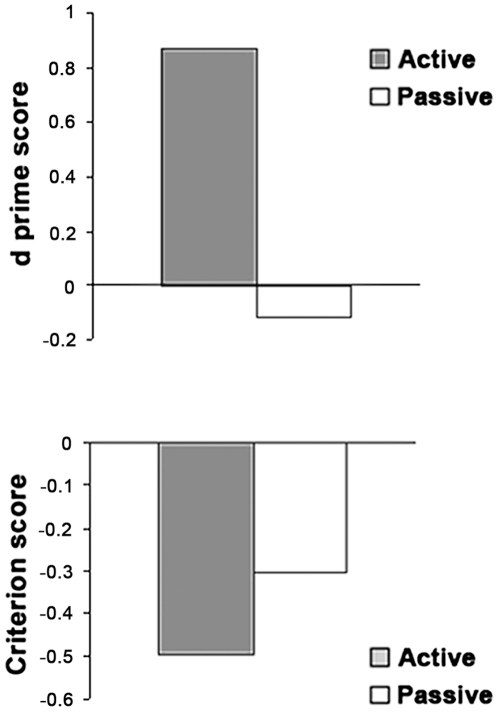
Signal Detection analysis of behavioural responses by conditions of movement ownership.
Upper panel: Sensitivity (d') in the active vs. passive condition. Lower panel: Criterion or response bias in the active vs. passive condition. Subjects were better at making the self vs. other discrimination (p<.05) and tended to judge the viewed hand to be their own in the active relative to the passive condition (p = .06).